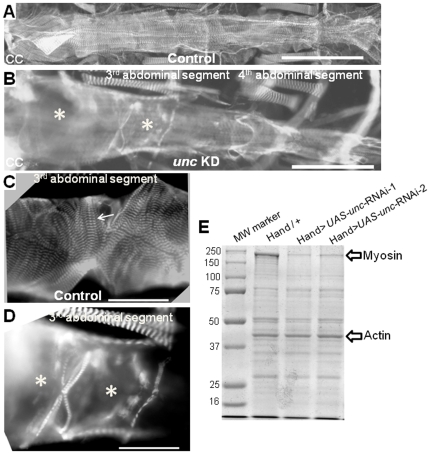
Structural dysfunction in unc-45 KD hearts due to impaired myosin accumulation.Immunofluorescence micrographs of 1 week old flies are shown. (A, C) Hearts from controls and (B, D) unc-45 KD flies were probed with antibody against muscle myosin. Control cardiac tubes show typical spiral myofibrillar arrangements within the cardiomyocytes (arrow). Myofibrillar organization is completely disrupted in the conical chamber and third segment of unc-45 KD cardiac tubes (indicated by *) with loss of most myosin-containing myofibrils and significant dilation. Enlarged image (D) of the third abdominal segment of an unc-45 KD heart demonstrates only a few myofibrils and gaps (missing myofibrils, indicated by *). Scale bars: 100 µM in A–B and 75 µM in C–D. (E) Myosin expression is significantly reduced in 1 week old unc-45 KD hearts, however, actin expression remain unchanged as shown by SDS-PAGE.